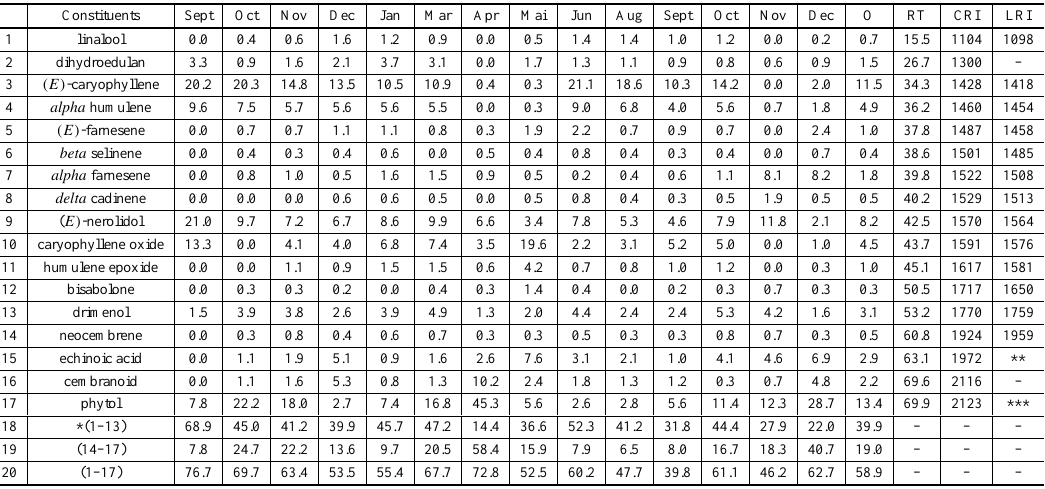
TABLEI Identified constituents of E. grandiflorus essential oils from BL-population with their percentage monthly recorded in GC-analysis for the period September 1998 to December 1999, together their mean percentage of oil (O), the mean retention time (RT) and the mean calculated retention indices (CRI) as well as the literature RI (LRI).